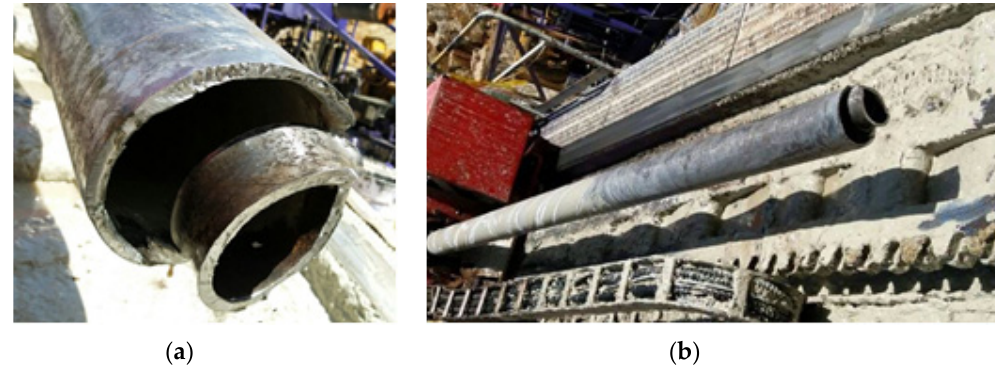
Figure 1. The failure of DS. (a) Partial enlargement. (b) Panorama.